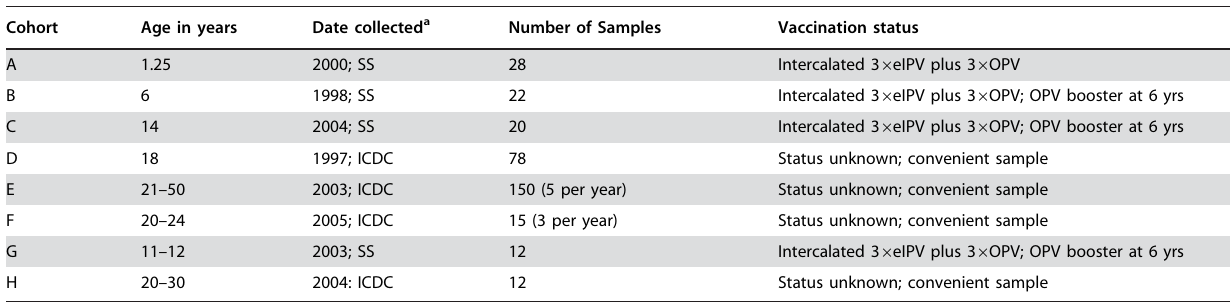
Table 2. Age-grouped cohorts used for determining GMT to type 2 poliovirus strains. .. ... .... ... ... .... ... ... .... ... ... .... ... ... .... ... ... .... ... ... .... ... ... .... ... ... .... ... ... .... ... ... .... ... ... .... ... ... .... ... ... .... ... ... .